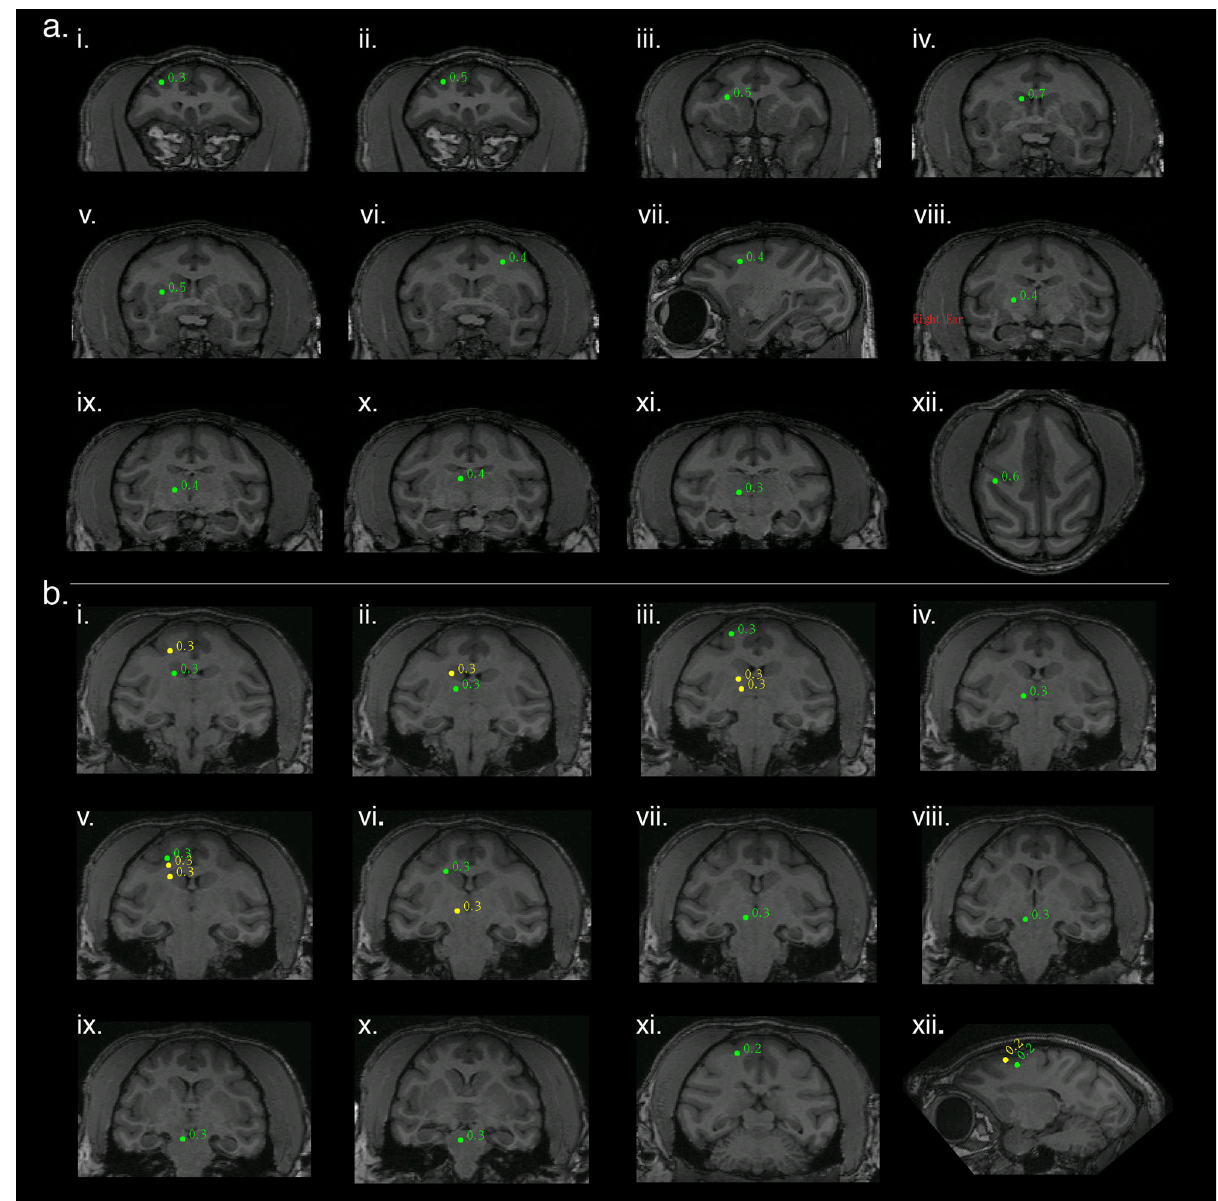
Fig. 4 Arcuate optogenetic stimulation results in propagation through conserved networks across animals. a Identi fi cation of cortico-striato-pallido- thalamo-cortical (CSPTC) network activity in response to 8 Hz sine wave stimulation of right arcuate sulcus in NHP M1. SAM analysis of optical input to arcuate sulcus reveals a known functional network with peaks in: ( i ) right inferior bank arcuate sulcus, ( ii ) right superior bank arcuate sulcus, the site of stimulation, ( iii ) right corona radiata/dorsolateral caudate n., ( iv ) right caudate n. ( v ) right putamen/ external segment of globus pallidus, ( vi ) and ( vii ) posterior bank of contralateral (left) arcuate sulcus, coronal and sagittal slices, respectively, ( viii ) right globus pallidus, ( ix ) right ventroposterior medial/ ventroposterior lateral n. of thalamus, ( x ) right medial dorsal n. of thalamus, ( xi ) right ventral posterior thalamus, and ( xii ) parietal-occipital association area of the intraparietal sulcus. b A second example of right hemispheric CSPTC network activity in a different NHP (M2) in response to 20 Hz square wave pulse trains with SAM peaks as follows: i caudate n. (green) and cortical area 3 (yellow), ( ii ) thalamus (green) and caudate n. (yellow), ( iii ) posterior dorsal bank of the arcuate sulcus (green) and two thalamic peaks (yellow), ( iv ) thalamus, ( v ) posterior ventral bank of arcuate sulcus (green, site of stimulation), corpus callosum (yellow), and caudate n. (yellow), ( vi ) caudate n. (green) and mesencephalic nuclei (yellow), ( vii ) mesencephalic n., ( viii ) substantia nigra, ( ix ) tegmental n., ( x ) pontine or mesencephalic n., and ( xi ), and ( xii ) all peaks in primary motor cortex (area